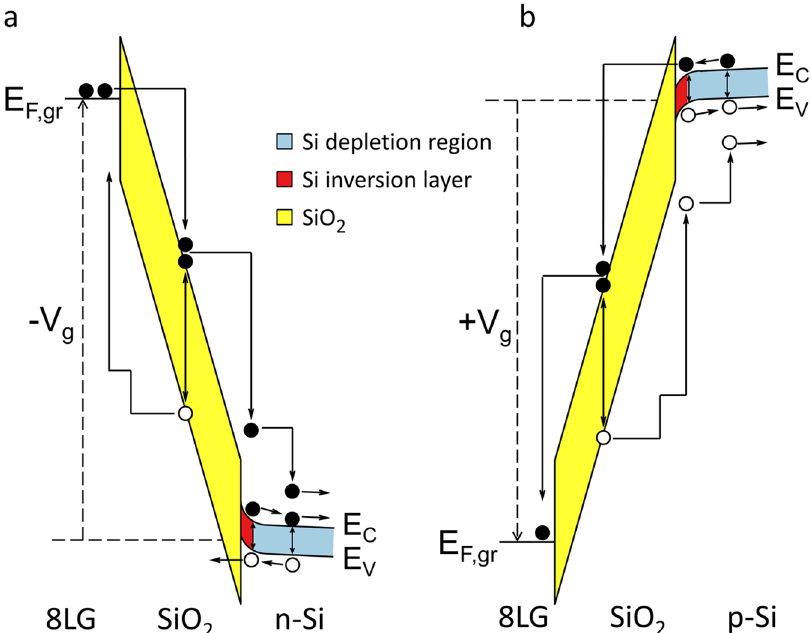
Figure 4. Carrier multiplications in GOS structure. ( a ) n-Si GOS under inversion bias. Note the cascade of impact ionizations occurring in SiO 2 and Si depletion region. The carrier multiplication intensifies in Si side. ( b ) p-Si GOS under inversion bias. The carrier multiplication intensifies towards graphene side. Note also the positive feedback effect induced by impact-ionization-generated holes in SiO 2